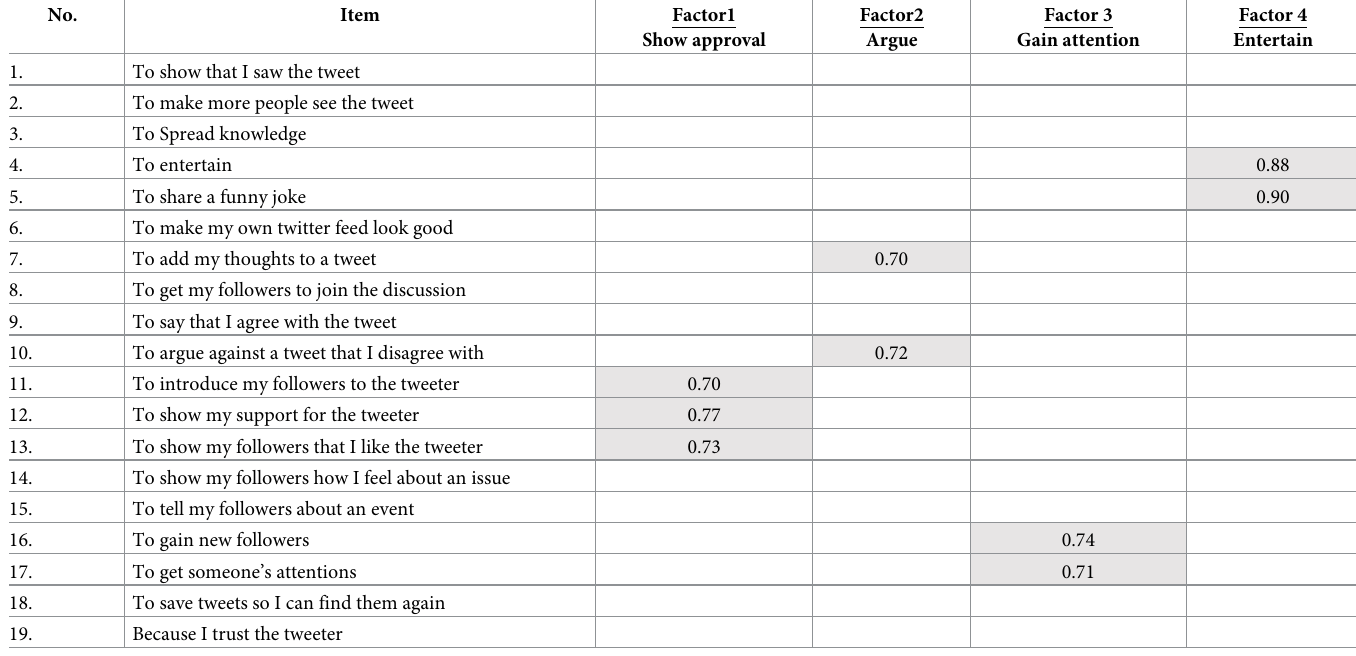
Table 2. Exploratory factor analyses item loadings (Varimax rotation) (N Training = 824).